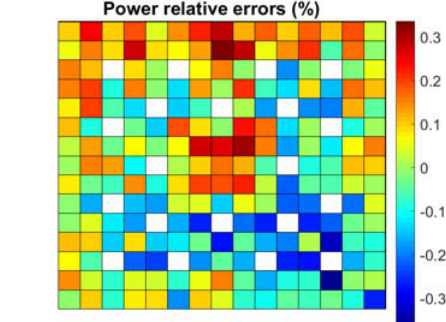
Figure 2: Effect of the missing isotopes on the power. Figure 3: 2D results for